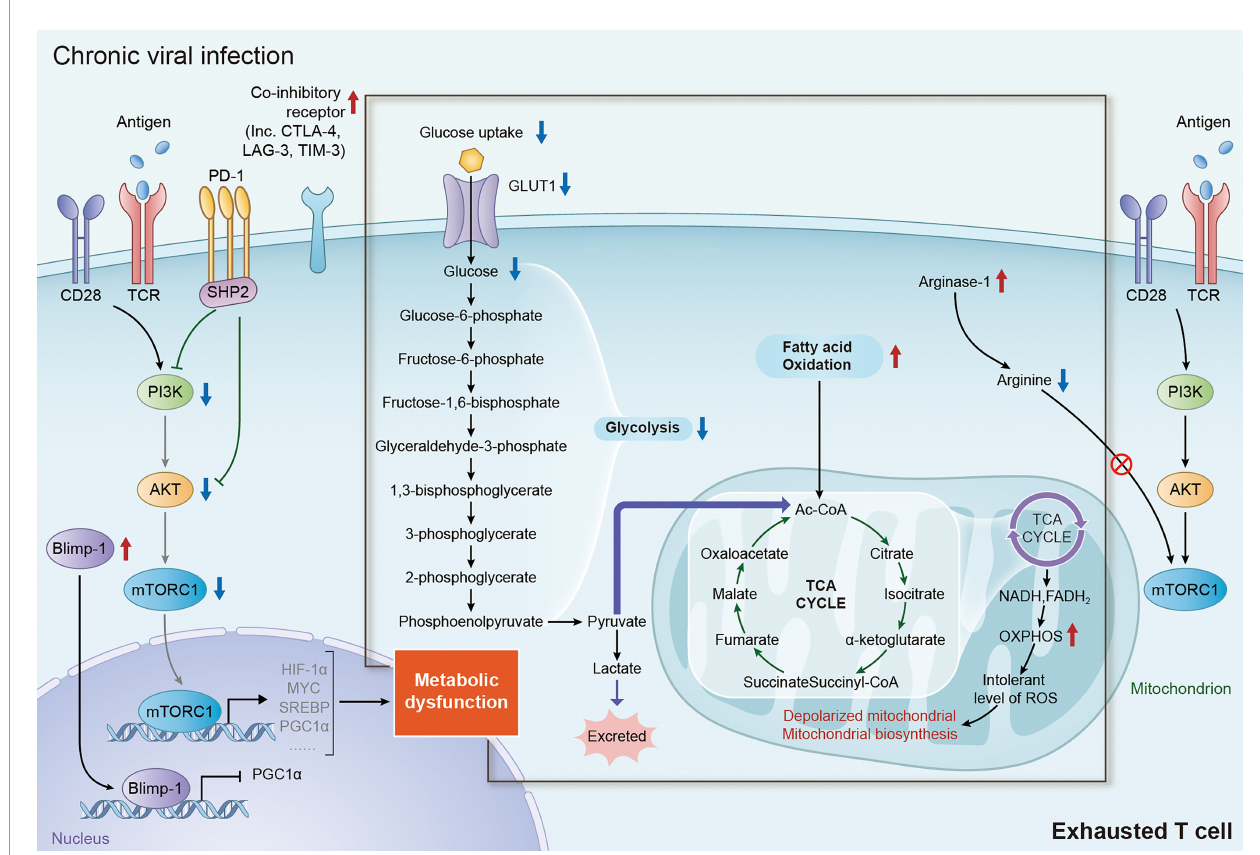
FIGURE 2 | Metabolic alteration of exhausted T cells in chronic viral infection. During chronic viral infection, continuous antigen stimulation via TCR signaling signi fi cantly increase the expression of multiple inhibitory and co-inhibitory receptors including PD-1, CTLA-4, TIM-3 and LAG-3, which subsequently block the signaling of PI3K/AKT/mTORC1 axis and decrease the expression of its downstream factor, inducing metabolic dysfunction in exhausted T cells. Elevated expression of Blimp-1 in exhausted T cells also induce metabolic dysfunction in exhausted T cells by repressing the expression of PGC1 a . It is well accepted that the shifting from glycolysis to FAO for energy generation is an important trigger of T-cell exhaustion. In addition, augmentation of FAO in mitochondria can lead to mitochondrial depolarization, impairment of mitochondrial biosynthesis and production of intolerable level of ROS, which are tightly associated with the dysfunction in exhausted T cells. TCR, T-cell receptor; PI3K, phosphoinositide 3-kinase; AKT, protein kinase B; mTORC1, mechanistic target of rapamycin complex 1; PD-1, programmed death-1; CTLA-4, cytotoxic T lymphocyte antigen-4; TIM-3, immunoglobulin domain and mucin domain-containing protein 3; LAG-3, lymphocyte activation gene 3 protein; PGC1 a , peroxisome proliferator-activated receptor gamma coactivator 1-alpha; FAO, fatty acid oxidation; ROS, reactive oxygen